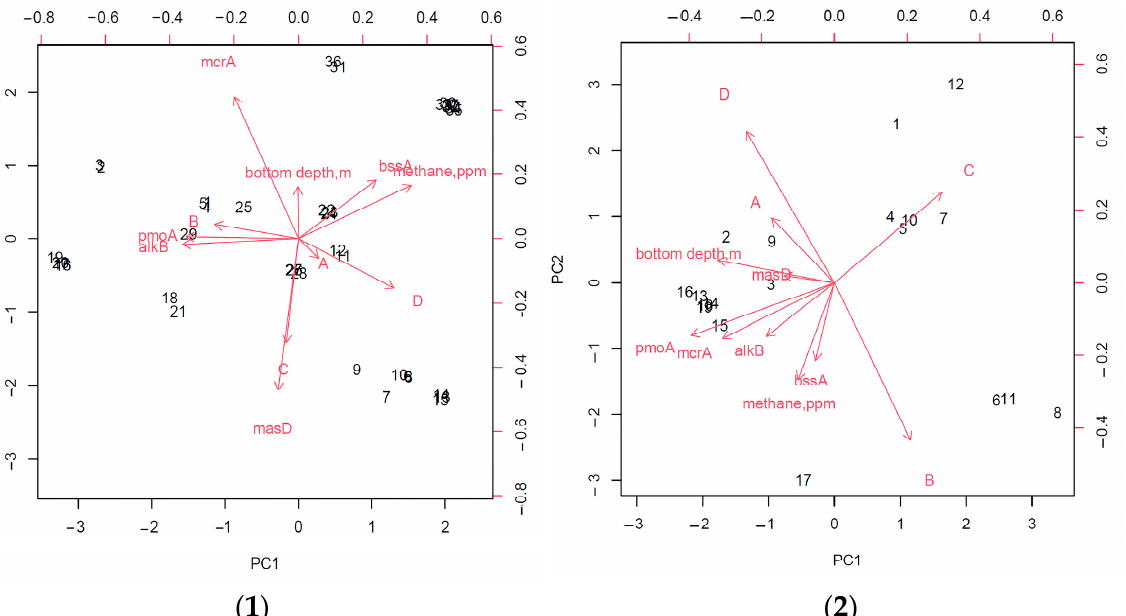
Figure 9. Relationships of the studied bioindicator signs throughout the study area without di- viding into gas-hydrate and non-gas-hydrate zones. (A) The degree of biodegradation of hydro- carbons under aerobic conditions; (B) the degree of biodegradation of hydrocarbons under anaer-